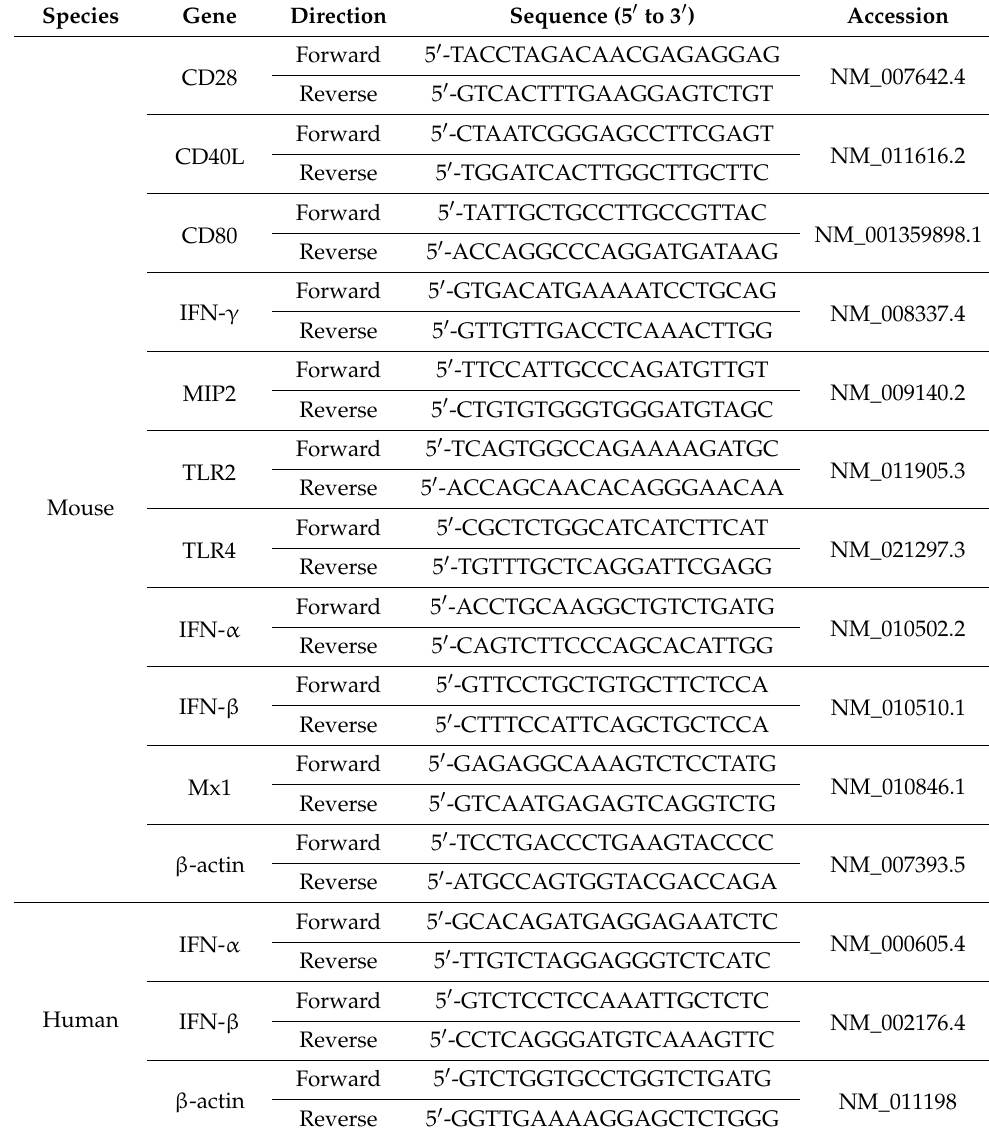
Table 1. List of gene-specific primers for immune-related